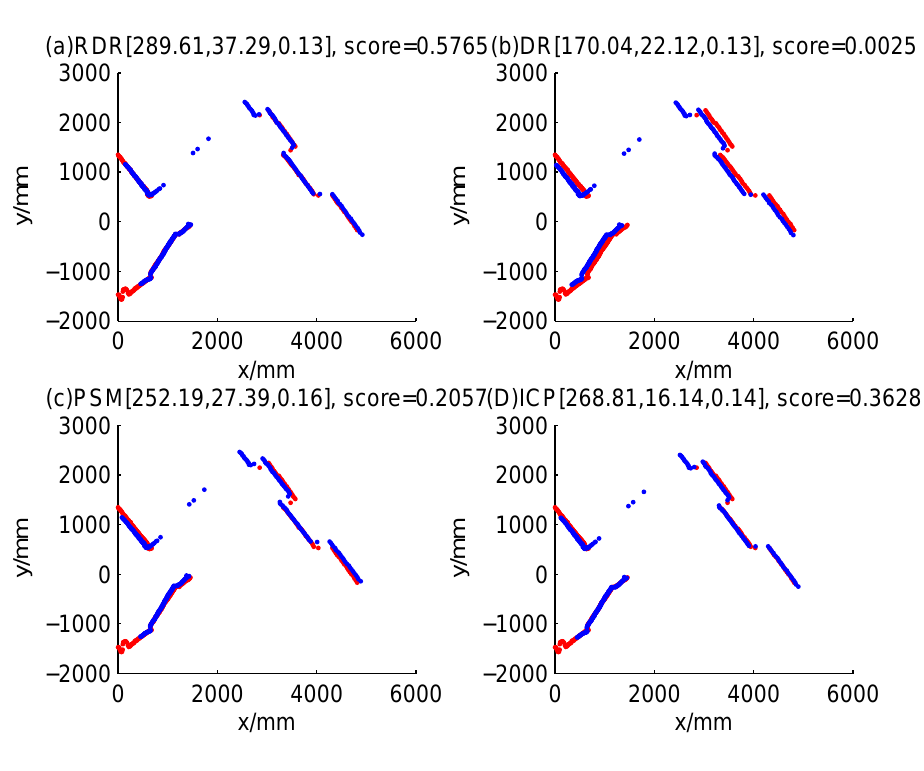
Figure 15. Robust dead reckoning result for Case 2a (time Step